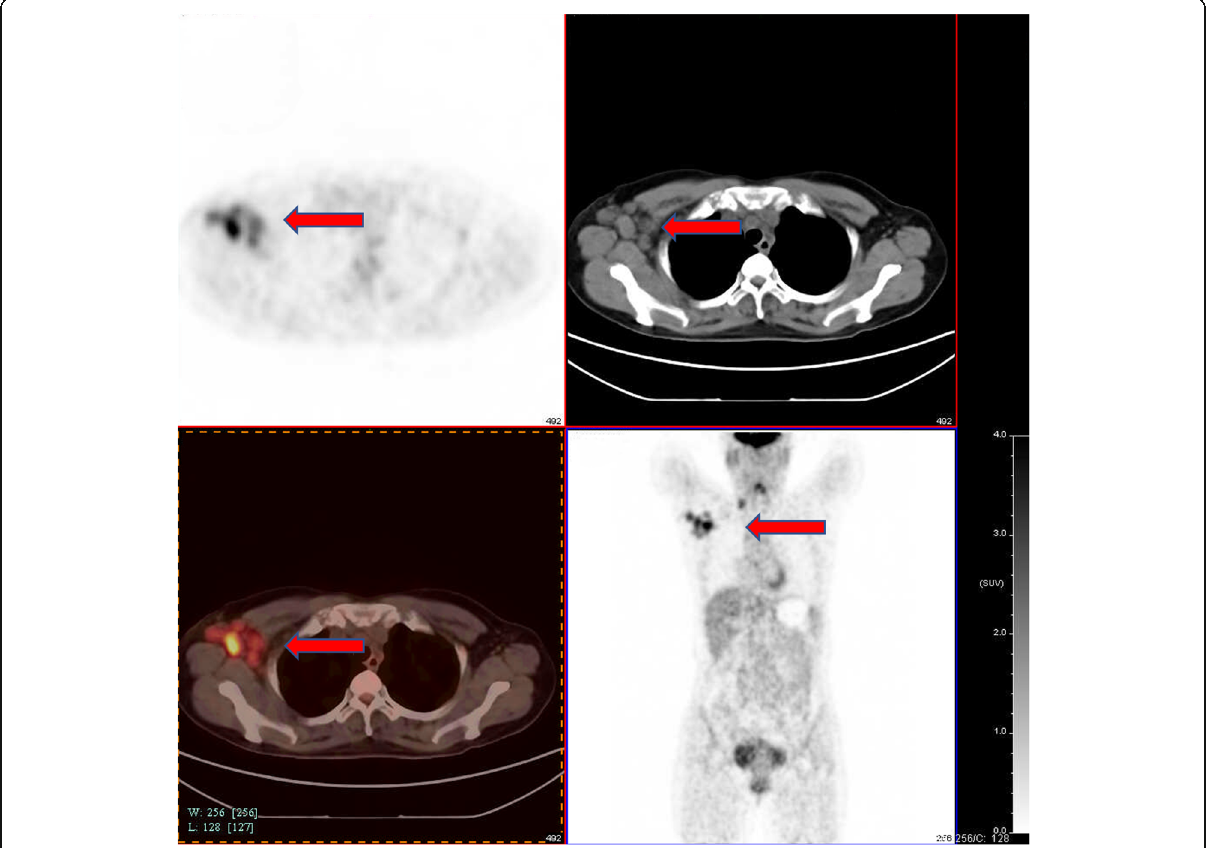
Fig. 1 PET-CT before axillary surgery. The initial staging showed multiple lesions with significantly increased FDG intensity presenting in the right side